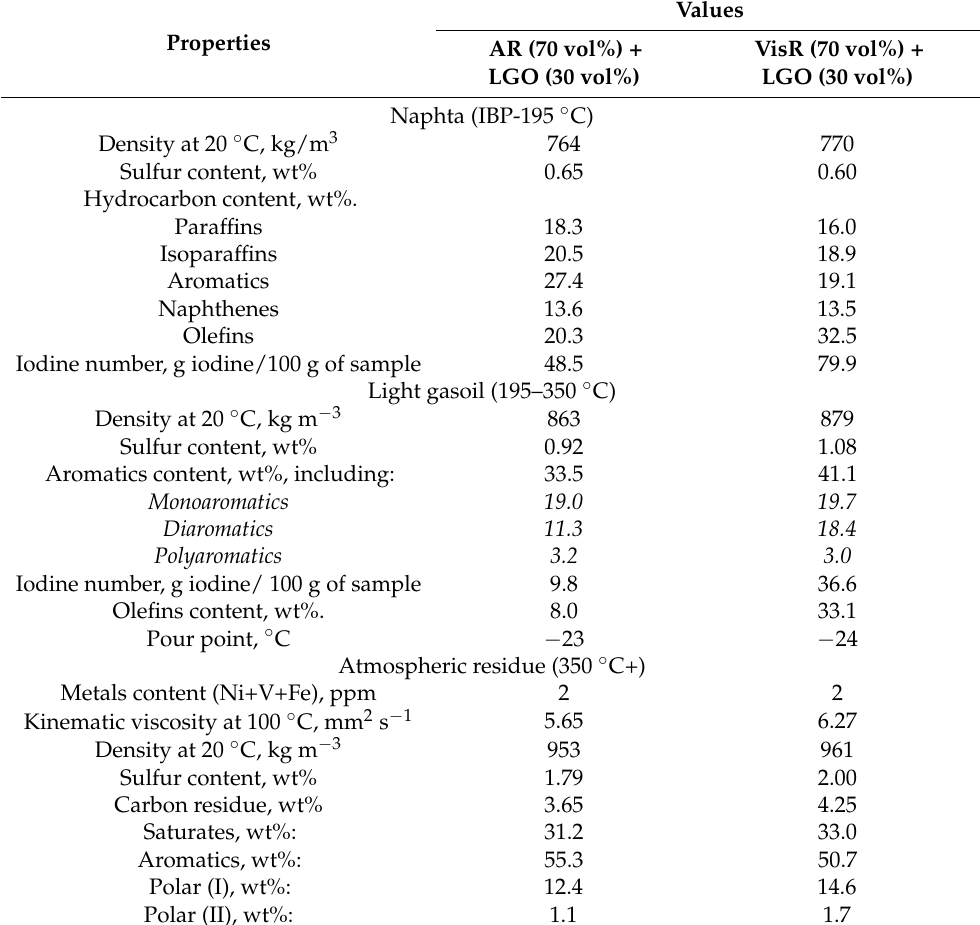
Table 5. Characteristics of adsorptive treatment liquid products (T = 485 ◦